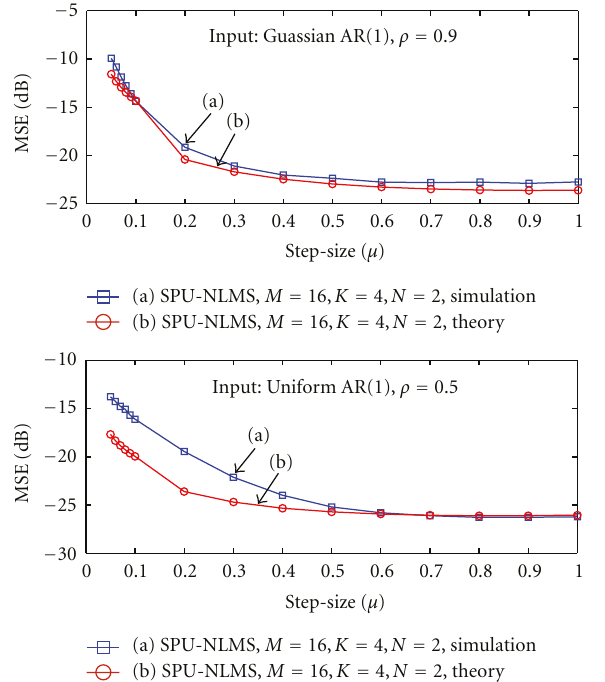
Figure 15: Steady-state MSE of SPU-NLMS with M = 16, K = 4 and N = 2 as a function of the step size in nonstationary environment for di ff erent input signals.